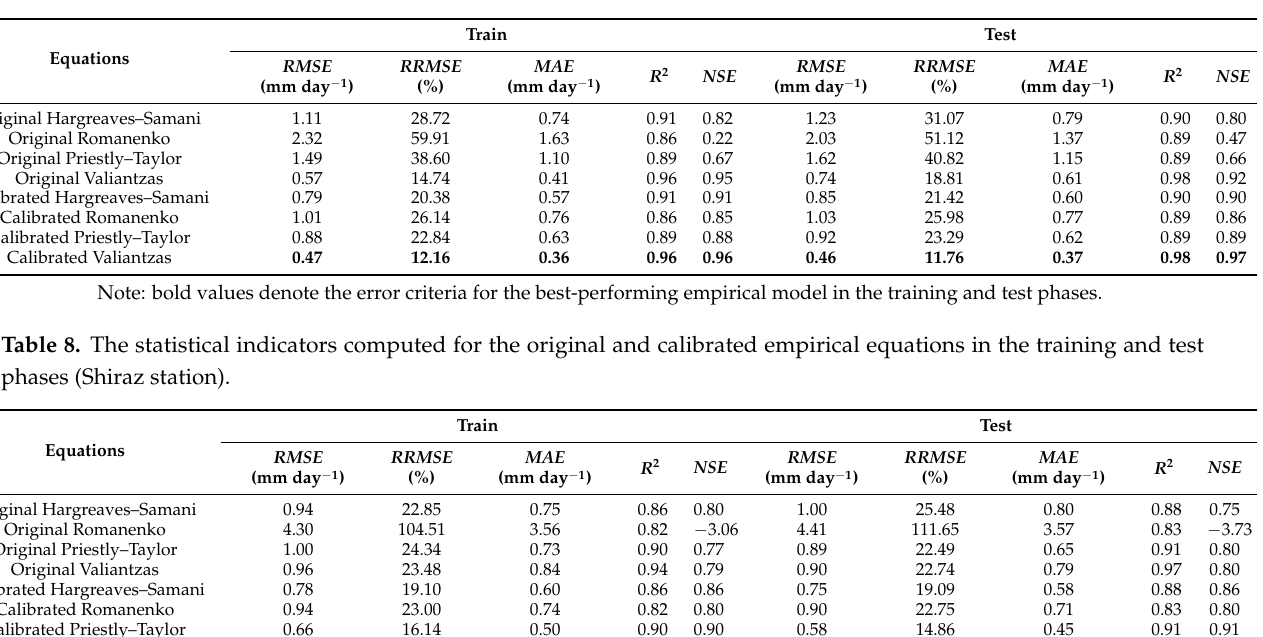
Table 7. The statistical indicators computed for the original and calibrated empirical equations in the training and test phases (Tabriz station).